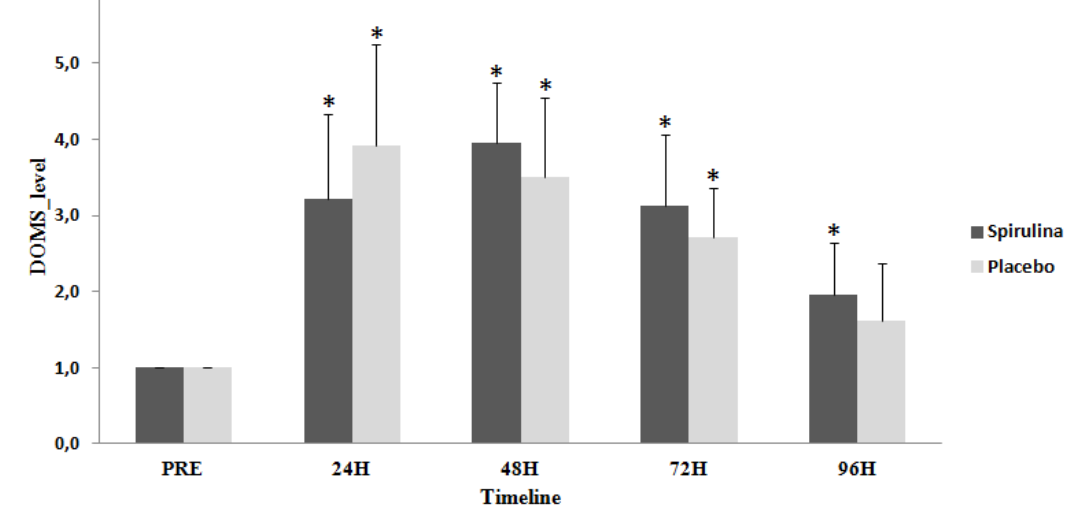
Figure 4. Change of Delay Onset Muscle Soreness (DOMS) in response to eccentric protocol. PRE, Baseline measurement; H, Hours; * Significant difference with PRE.